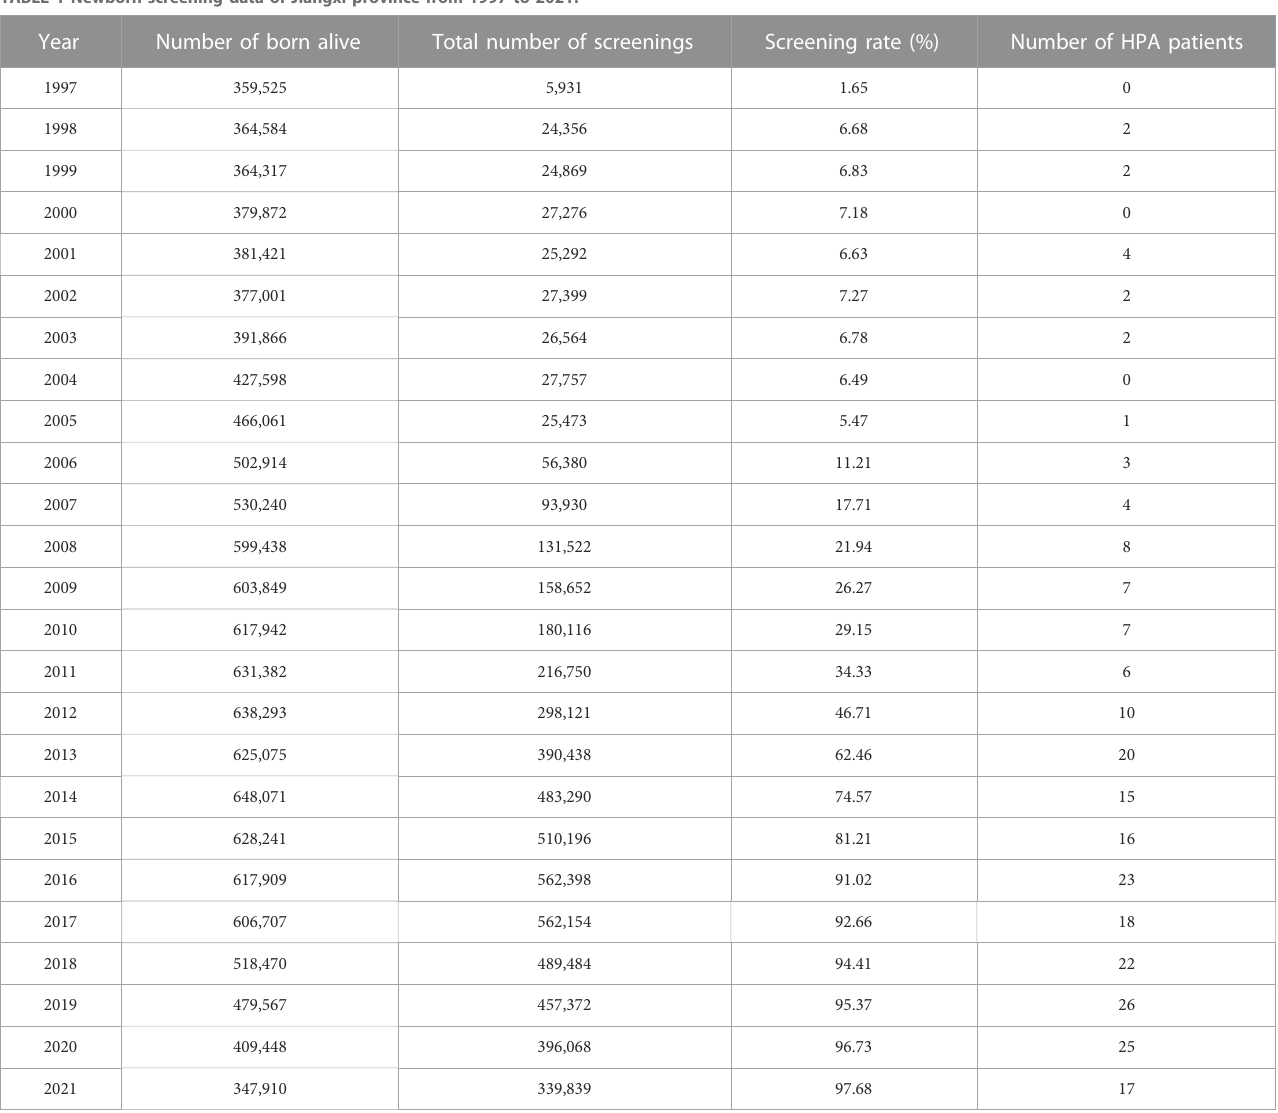
TABLE 1 Newborn screening data of Jiangxi province from 1997 to